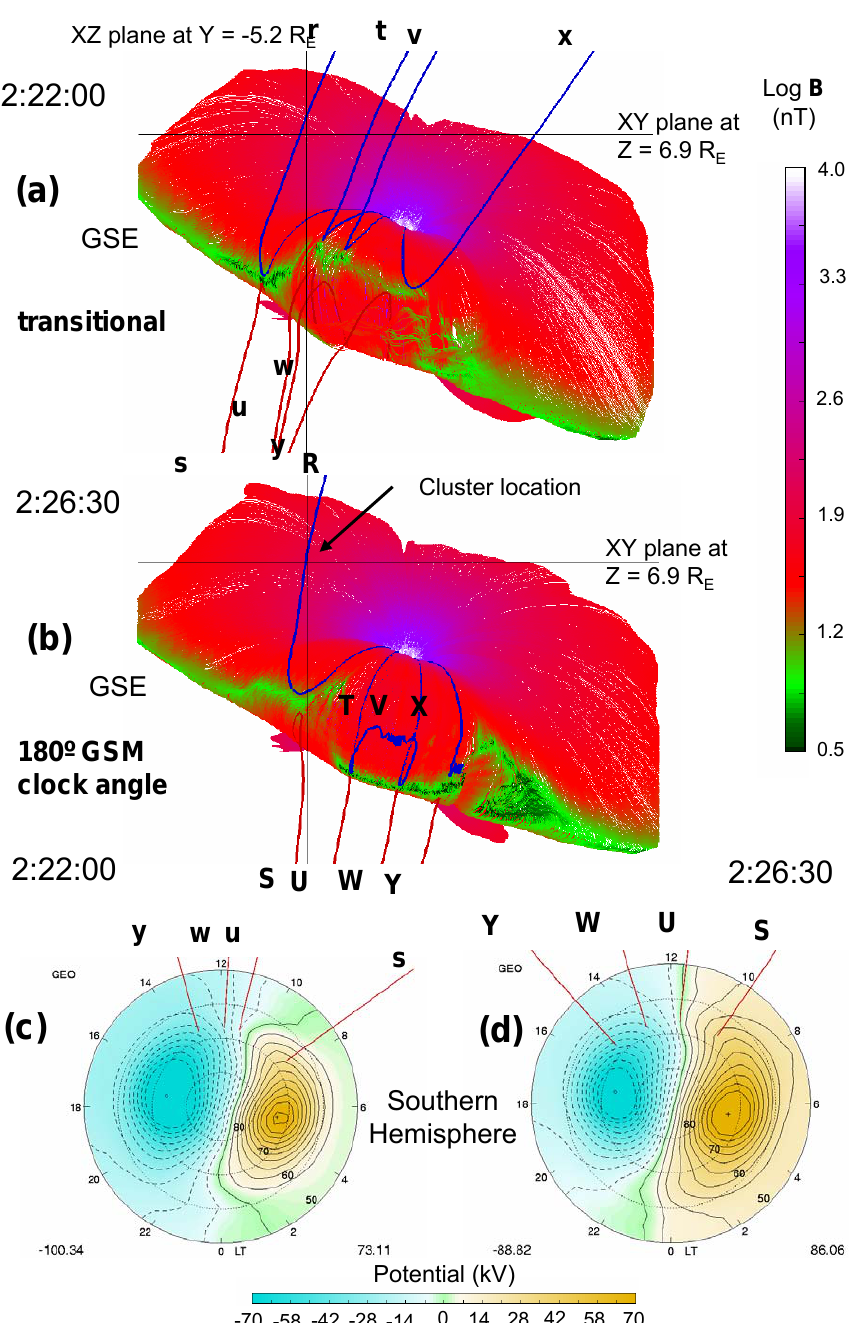
Fig. 10. Results from an ISM simulation with input conditions during and after the transition to 180 ◦ clock angle. The format is similar to Fig. 4. (a) and (b) The 3-dimensional magnetopause as defined by the sets of last closed field lines mapped from the northern and southern hemisphere ionospheres in GSE coordinates. The field lines are colored with the log of the magnitude of the magnetic field. Regions of low magnetic fields (green and black) on the magnetopause surface are proxies for possible merging locations. Four pairs of first open field lines, labeled r through y for the transition time and R through Y for the time after the transition, highlight regions of importance in interpreting the 557.7 nm emissions (see text). The foot-points of the field lines in the southern hemisphere ionosphere for each case are shown in (c) and (d) with the respective potential patterns as